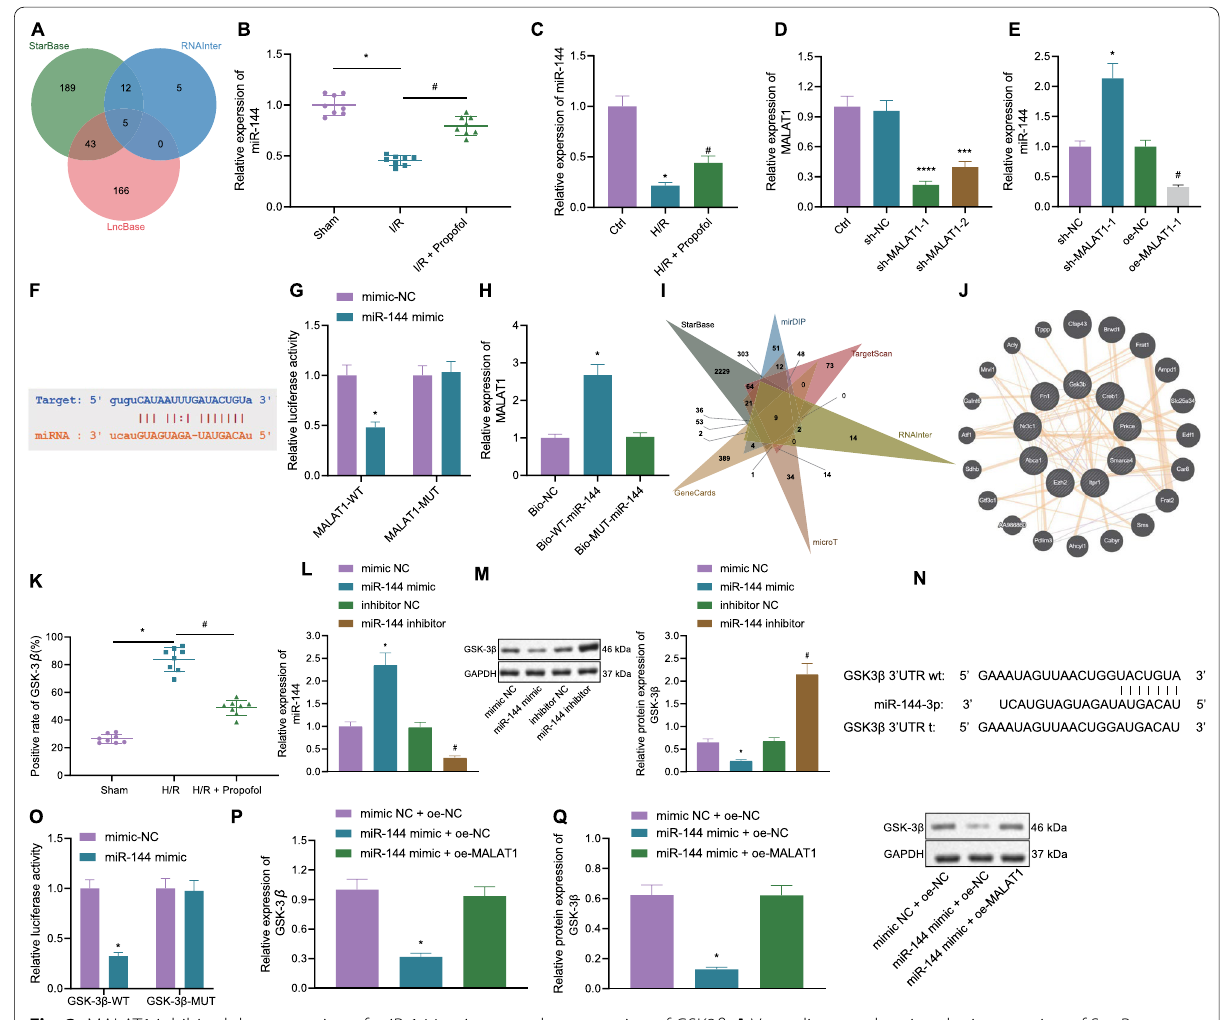
Fig. 3 MALAT1 inhibited the expression of miR‑144 to increase the expression of GSK3β. A Venn diagram showing the intersection of StarBase (http:// starb ase. sysu. edu. cn/), RNAInter (http:// www. rna‑ socie ty. org/ rnain ter/, Score 0.99), LncBase (http:// carol ina. imis. athena‑ innov ation. gr/ ≥ diana_ Tools/ web/ Index. php?R lncba sev2% 2Find ex, Score 0.9) results using the jvenn online tool (http:// jvenn. toulo use. inra. fr/ app/ examp le. = ≥ html). B Expression of miR‑144 in lung tissues of mice as detected by RT‑qPCR (8 mice in each group; * p < 0.05, compared with that of the sham group; # p < 0.05, compared with the I/R group). C Expression of miR‑144 in cells as detected by RT‑qPCR (* p < 0.05, compared with the control group; # p < 0.05, compared with the H/R group). D MALAT1 silencing efficiency as determined by RT‑qPCR (*** p 0.0001, compared with the = sh‑NC group; **** p < 0.0001, compared with the sh‑NC group). E Expression of miR‑144 in cells as determined by RT‑qPCR (* p < 0.05, compared with the sh‑NC group; # p < 0.05, compared with the oe‑NC group). F Binding sites between MALAT1 and miR‑144 as predicted by StarBase. G Binding relationship between MALAT1 and miR‑144 as verified by dual‑luciferase reporter gene assay (* p < 0.05, compared with mimic NC). H Binding of MALAT1 to miR‑144 as measured by RNA pull‑down (* p < 0.05, compared with Bio‑NC). I Venn diagram showing the intersection of StarBase, mirDIP (http:// ophid. utoro nto. ca/ mirDIP/, Score > 0.5), TargetScan (http:// www. targe tscan. org/ vert_ 72/), RNAInter (http:// www. rna‑ socie ty. org/ rnain ter/, Score > 0.6) and microT (http:// diana. imis. athena‑ innov ation. gr/ Diana Tools/ index. php?R microT_ CDS/, Score > 0.9) results and = I/R‑related genes. J Co‑expression network as plotted using GeneMANIA tool (http:// genem ania. org/). K Expression of GSK3β in mice as assessed by immunohistochemistry (8 mice each group; * p < 0.05, compared with that of the sham group; # p < 0.05, compared with the I/R group). L miR‑144 overexpression and silencing efficiencies (* p < 0.05, compared with mimic NC; # p < 0.05, compared with inhibitor NC). M Expression of GSK3β in cells as assessed by Western blotting (* p < 0.05, compared with mimic NC; # p < 0.05, compared with inhibitor NC). N Binding sites and mutant sites between miR‑144 and GSK3β. O Binding relationship between miR‑144 and GSK3β as verified by dual‑luciferase reporter gene assay (* p < 0.05, compared with mimic NC). P GSK3β expression in cells as determined by RT‑qPCR (* p < 0.05, compared with mimic NC). Q GSK3β expression in cells as determined by Western blotting (* p < 0.05, compared with mimic NC oe‑NC). Cellular experiments were repeated 3 times +